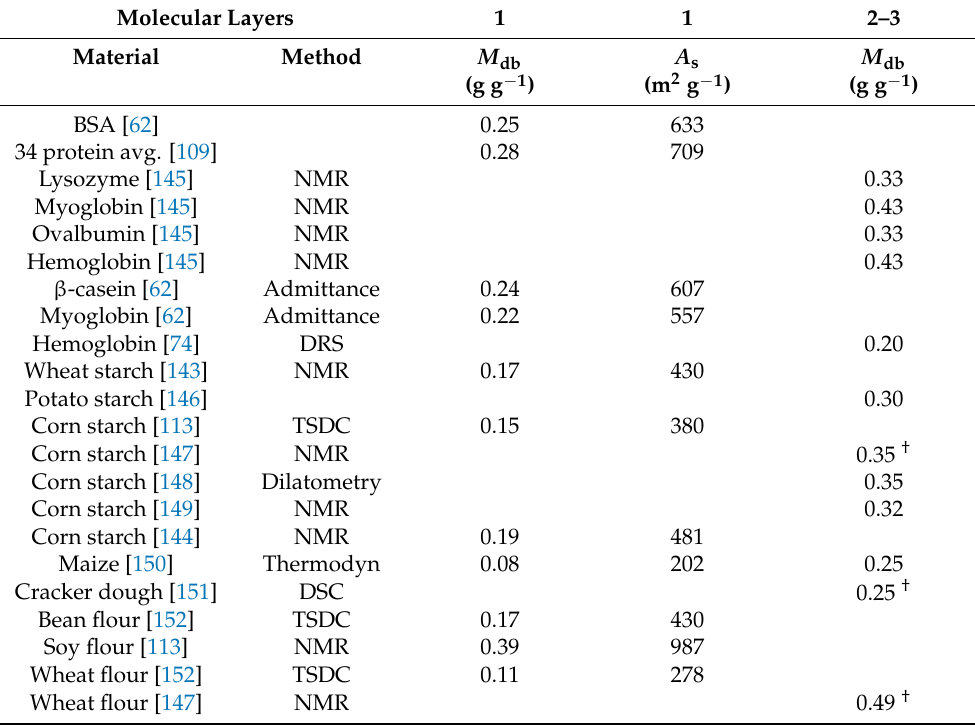
Table 6. Estimated specific surface area and water content (db) of mono- and multi-layered bound water measurements in various proteins, starches and